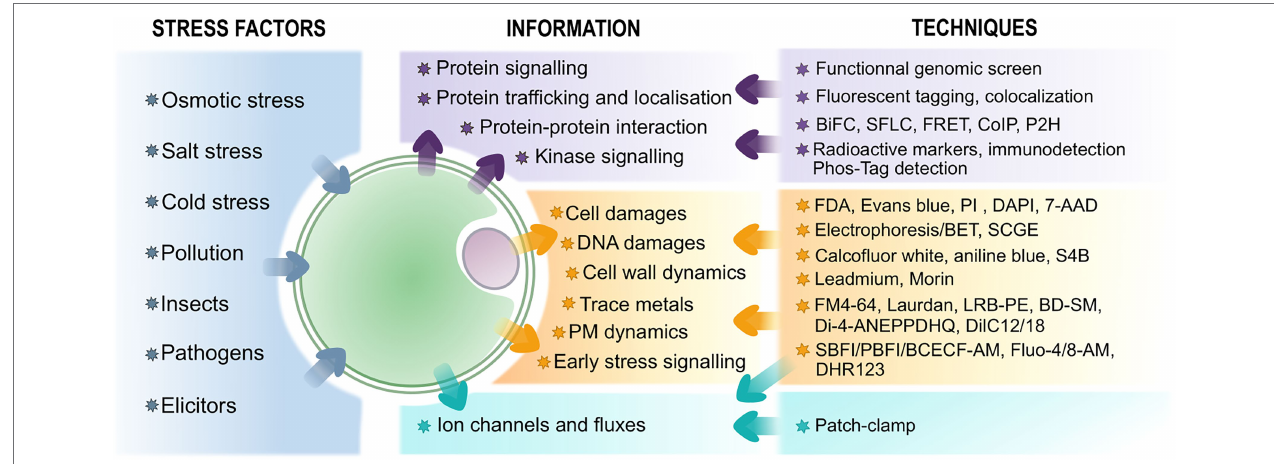
FIGURE 1 | Overview of techniques associated with protoplasts to study plant stress perception and response and the information they provide. The biomolecular- related assays are in purple, fluorescence probes-associated techniques are in orange – see text for further information on the probes, and electrophysiological approaches are in